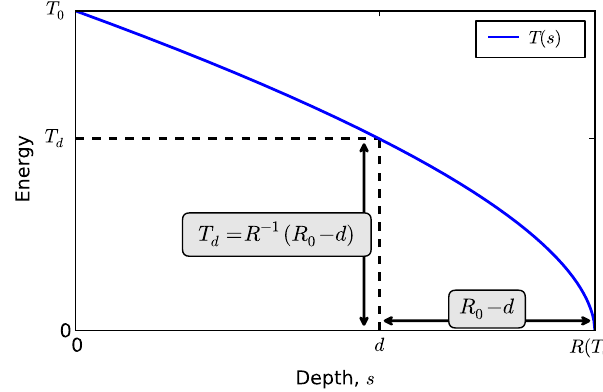
FIG. 2. Typical energy-loss curve in a homogeneous material. At a depth d , the residual beam range is R